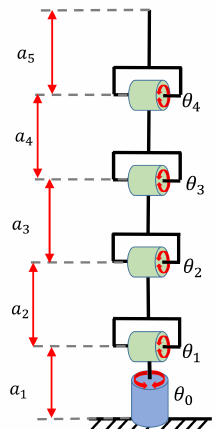
Figure 13. Dimensions and motion range of the five DOF manipulator.